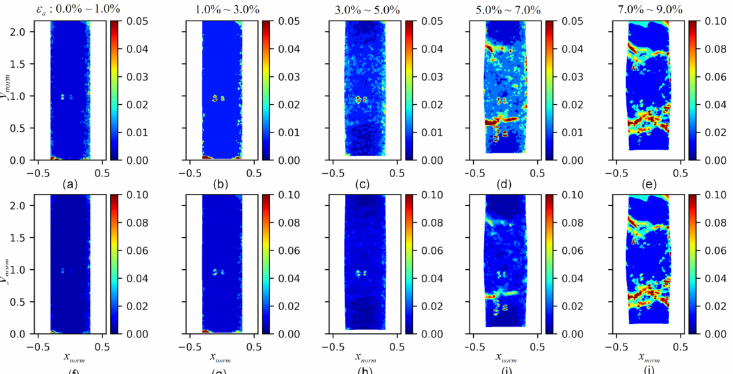
Figure 12. The evolution of the standard deviation fields of divergence div U : ( a – e ) the standard deviation fields of div U at axial strains of 0.0–1.0%, 1.0–3.0%, 3.0–5.0%, 5.0–7.0%, and 7.0–9.0%, respectively, with varying range colormaps; ( f – j ) the standard deviation fields of div U at axial strains of 0.0–1.0%, 1.0–3.0%, 3.0–5.0%, 5.0–7.0%, and 7.0–9.0%, respectively, with consistent range